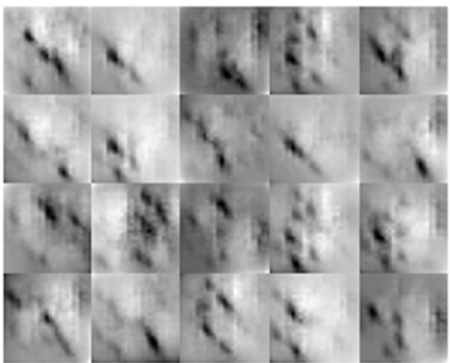
Figure 10. Visualization of the DCNN DND network’s third convolutional layer response for random inputs.